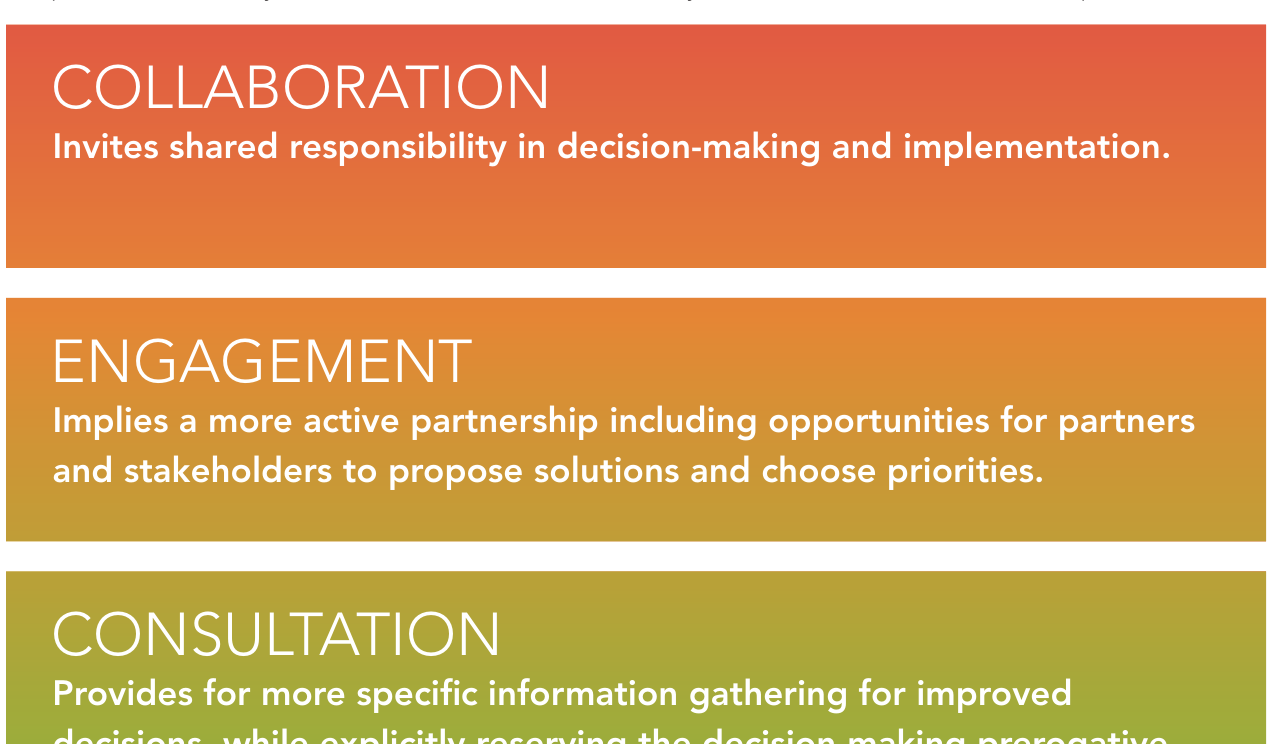
FIGURE 7. SPECTRUM OF COLLABORATION Adapted from the Policy Consensus Initiative & National Policy Consensus Center. 112,113 Used with